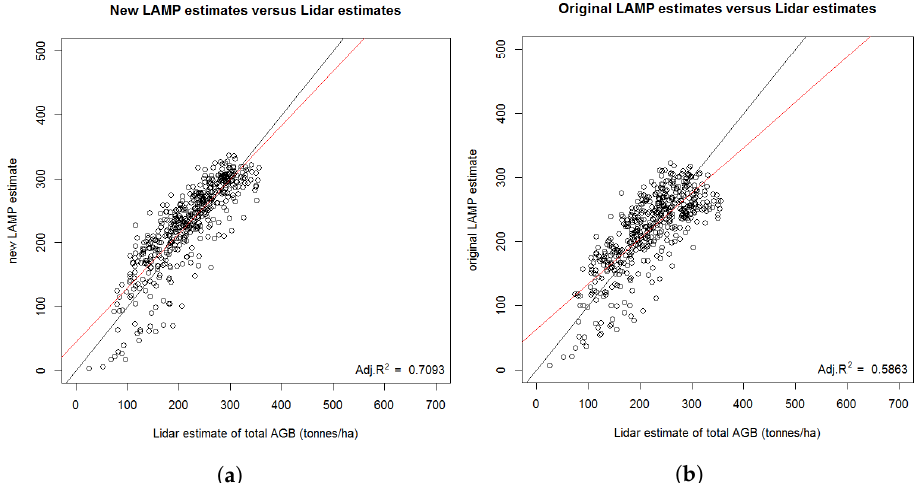
Figure A3. AGB predictions with LAMP3 at 10-hectare scale compared to Lidar estimates. ( a ) OLSLAMP; ( b ) LAMP3. Regression trend line of the linear model in red, optimal trend line in